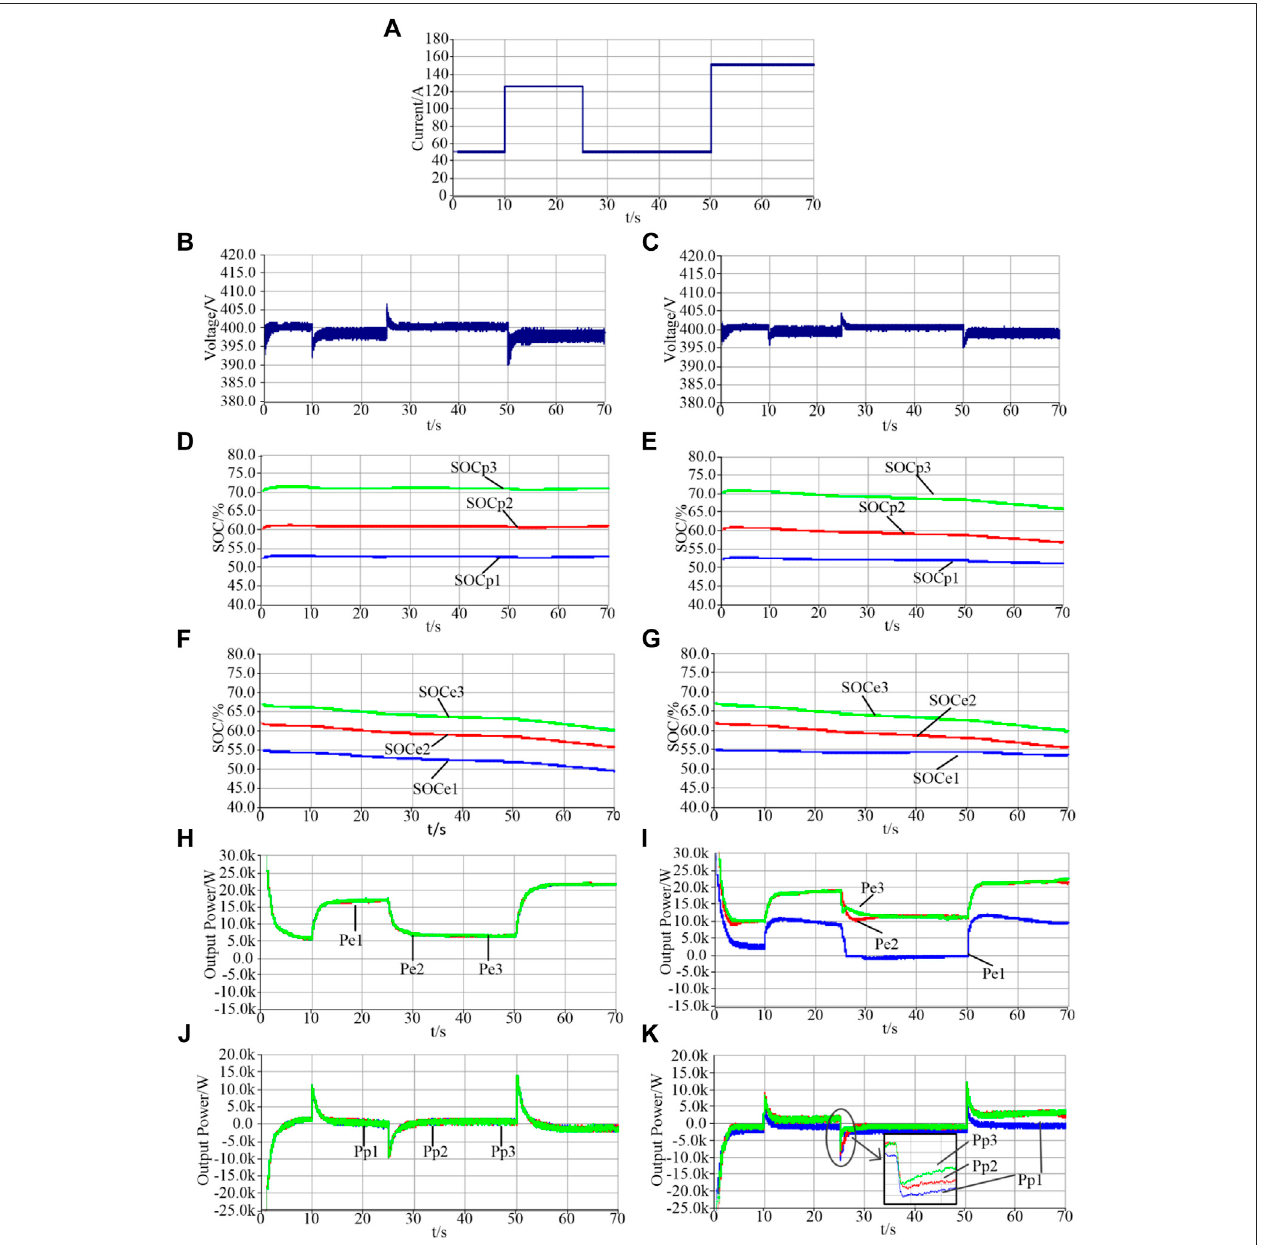
FIGURE 11 | Simulation results under step load condition: (A) Load current; (B) Bus voltage-No SOC regulation; (C) Bus voltage-SOC regulation; (D) High-Power Battery SOC-No SOC regulation; (E) High-Power Battery SOC-SOC regulation; (F) High-Energy Battery SOC-No SOC regulation; (G) High-Energy Battery SOC-SOC regulation; (H) TheoutputpowerofHigh-EnergyBattery-NoSOCregulation; (I) TheoutputpowerofHigh-EnergyBattery-SOCregulation; (J) TheoutputpowerofHigh- Power Battery-No SOC regulation; (K) The output power of High-Power Battery-SOC